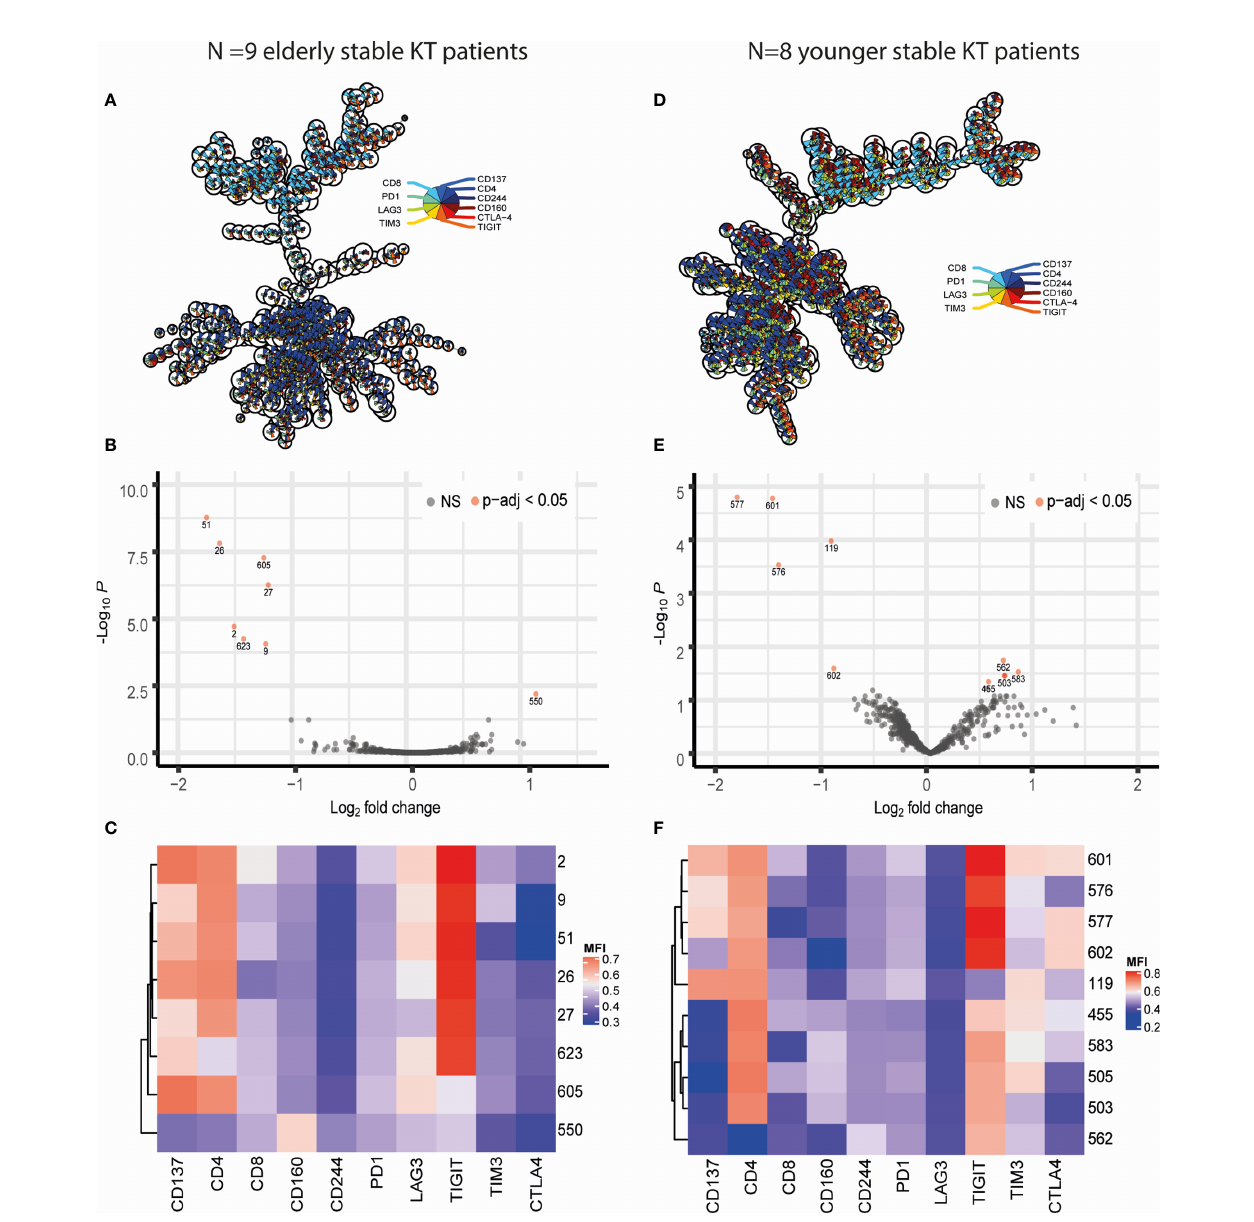
FIGURE 1 | Visualization of FlowSOM and diffcyt results obtained through comparing CD3 T cells stimulated with donor antigen from pre and post KT. Panels on the left (A – C) contain data obtained from comparing pre- vs post-KT donor-stimulated T cells in N=9 elderly recipients while those on the right (D – F) resulted from comparing pre- vs post-KT donor-stimulated T cells in N=8 young KT recipients. (A, D) Minimal spanning trees (MST) represent the 625 clusters created with FlowSOM. Each ‘ node ’ representing a cluster contains a pie chart which illustrates the mean marker values. The nodes placed near each other have similar marker expression pro fi les. (B, E) Volcano plots of diffcyt results for each FlowSOM cluster showcasing the negative log base 10 of the adjusted p-values on the y axis and log base 2 of the fold change from pre to post KT on the x axis. TopDA clusters with a p adjusted value below 0.05 (highly signi fi cant) are highlighted in red. (E, F) The median fl uorescence intensity (MFI) expression pro fi le of each topDA cluster is illustrated in a heatmap with rows representing each cluster and columns the markers of interest. ns, non-signi fi